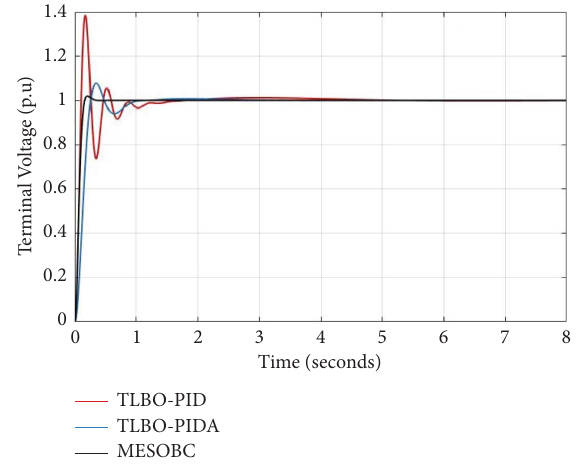
Figure 11: Response of terminal voltage with +50% uncertainties in K